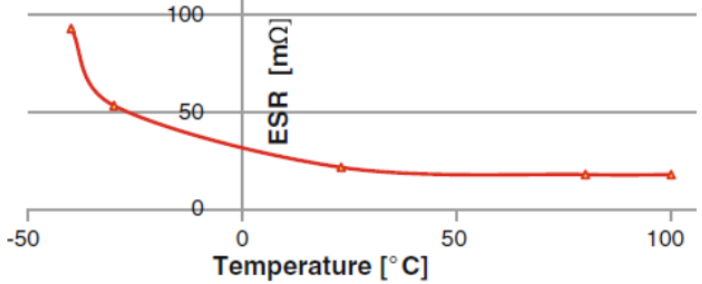
Figure 3. Thermal dependence of the ESR on temperature.